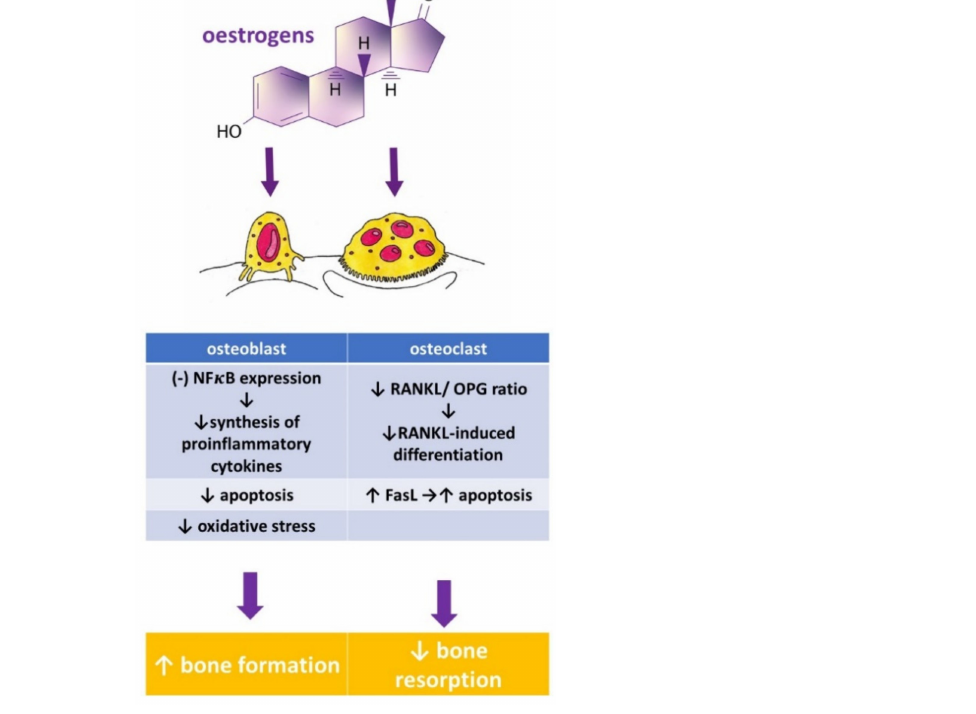
Figure 2. Influence of oestrogens on osteoblast and osteoclast function, and bone turnover. FasL—Fas